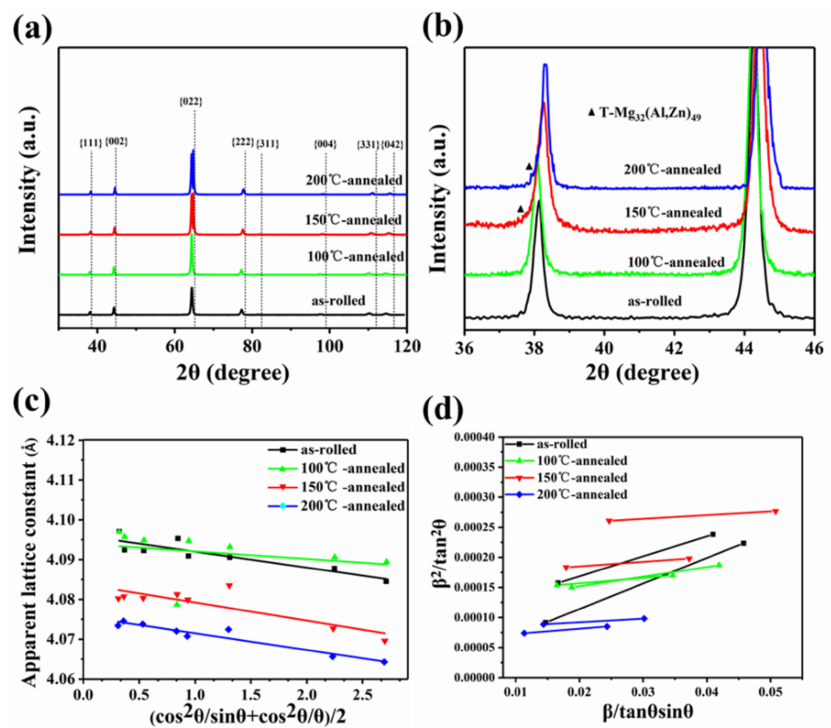
Figure 6. ( a ) XRD patterns of the Al-10.0Mg-1.0Zn-0.15Cu (wt%) alloy, ( b ) local amplification of ( a ), ( c ) apparent lattice constant a ( θ ) vs. (cos 2 θ /sin θ + cos 2 θ / θ )/2 and the fitted straight lines, and ( d ) β 2 /tan 2 θ vs. β /tan θ sin θ and the corresponding connecting straight